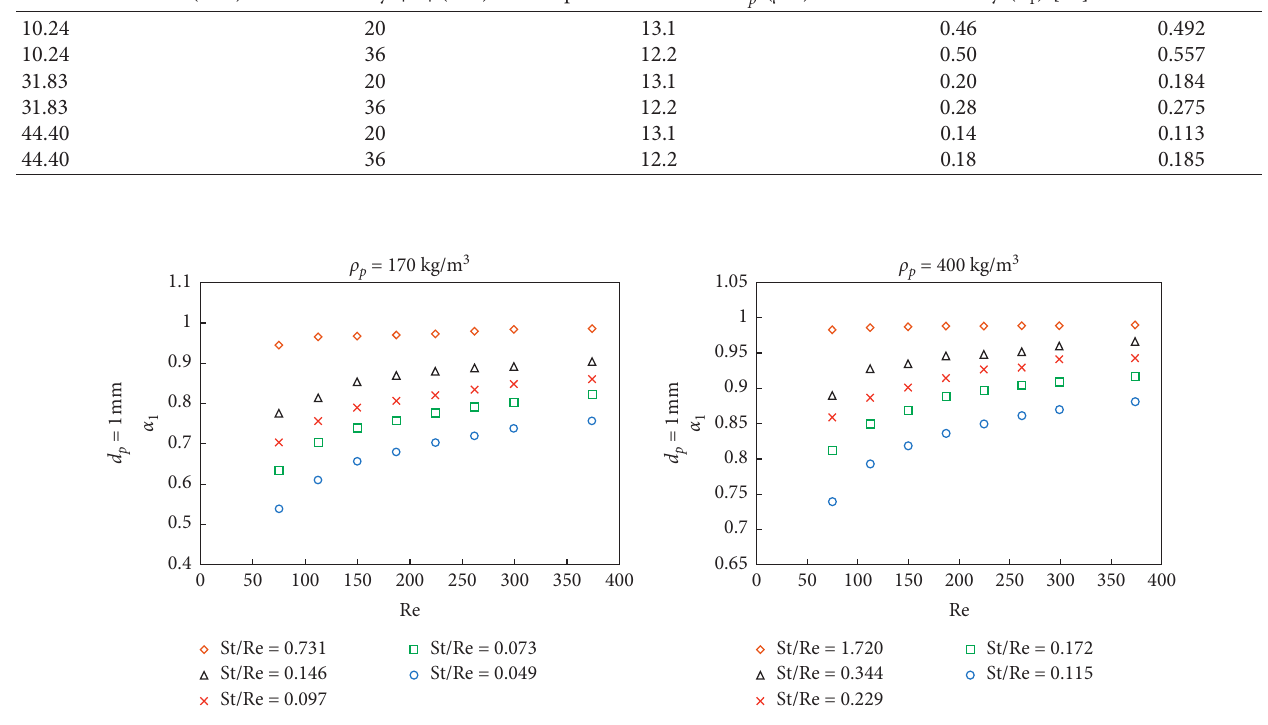
) study for different cable diameters D , snow particle diameters ( d p ), and wind velocities 1